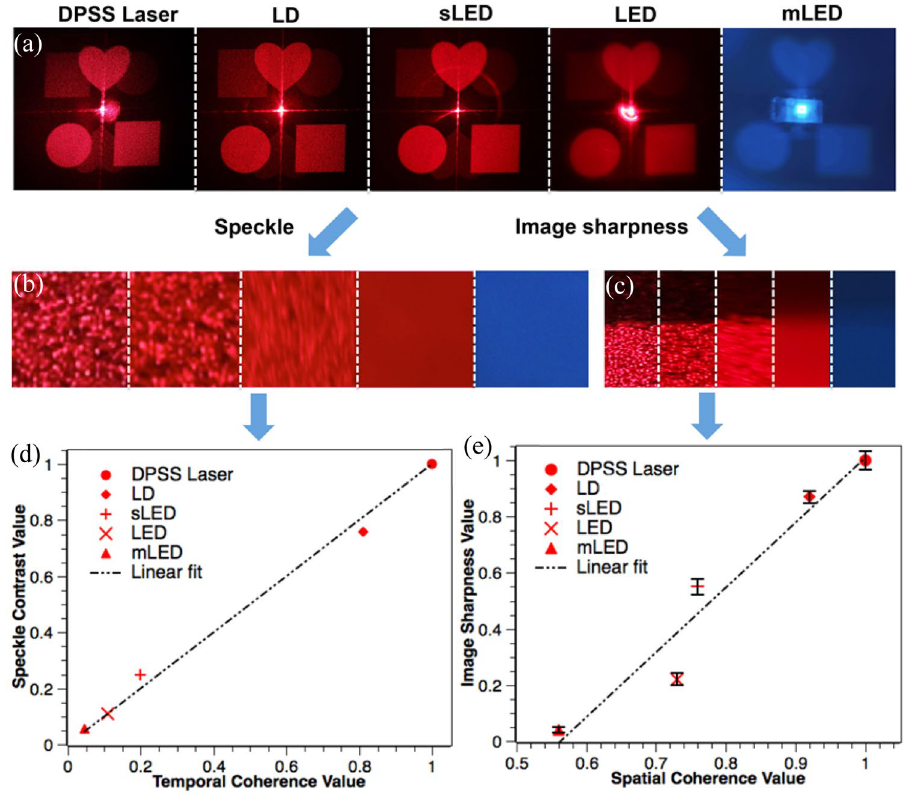
Figure 10. ( a ) Reconstructed images of the same target image for different light sources, from left to right in the first row are DPSS laser, LD, sLED, LED and mLED. ( b ) Enlarged images showing the details of speckle in the same area of interest for these light sources. ( c ) Enlarged images showing image edge in the same area of interest for these light sources. ( d ) Relation between temporal coherence value and speckle contrast value. ( e ) Relation between spatial coherence value and image sharpness value.